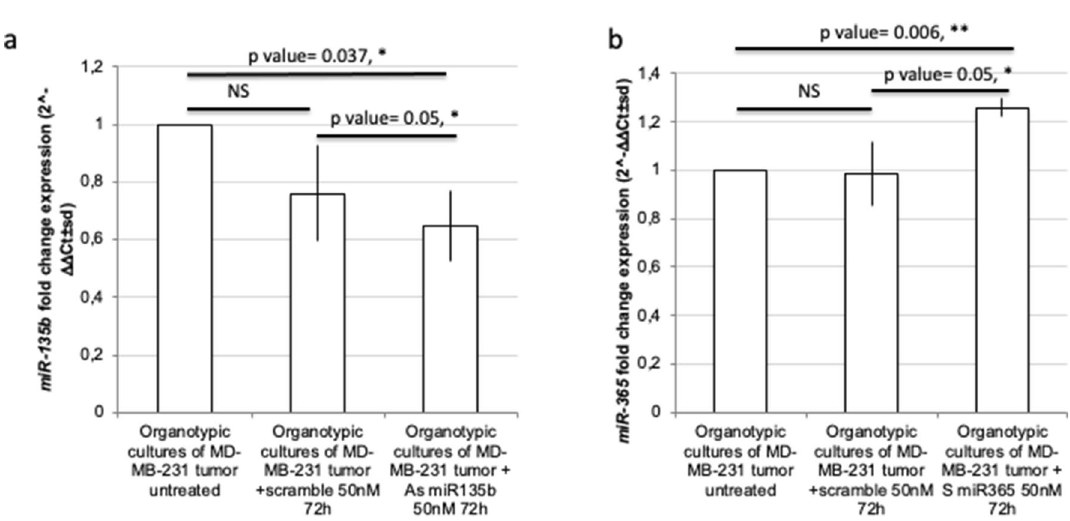
Figure 6. Therapeutic treatment with miR-135b and miR-365 oligonucleotides in MDA-MB-231 organoids modulates their expression. miR-135b ( a ), and miR-365 ( b ) fold change expression levels were evaluated by RT-qPCR analysis in human organotypic-like cultured slices obtained from MDA-MB-231 tumors, in vitro treated with 50 nM 72 h of As miR-135b or S miR-365 oligonucleotides. The average of two independent experiments is depicted. T test, p value < 0.05(*), 0.01